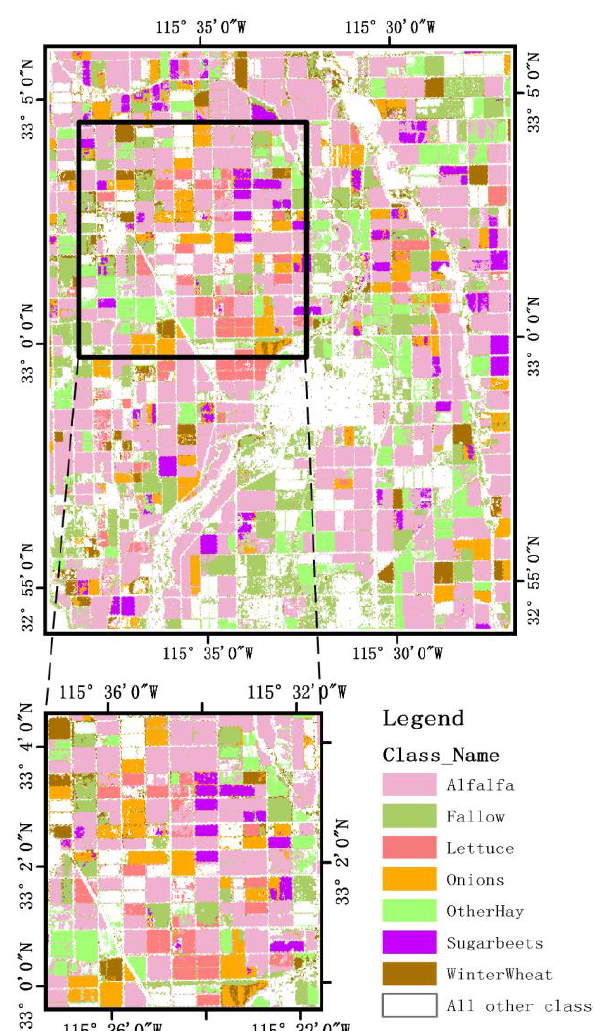
Figure 2. Spatial distribution of target crops in the study